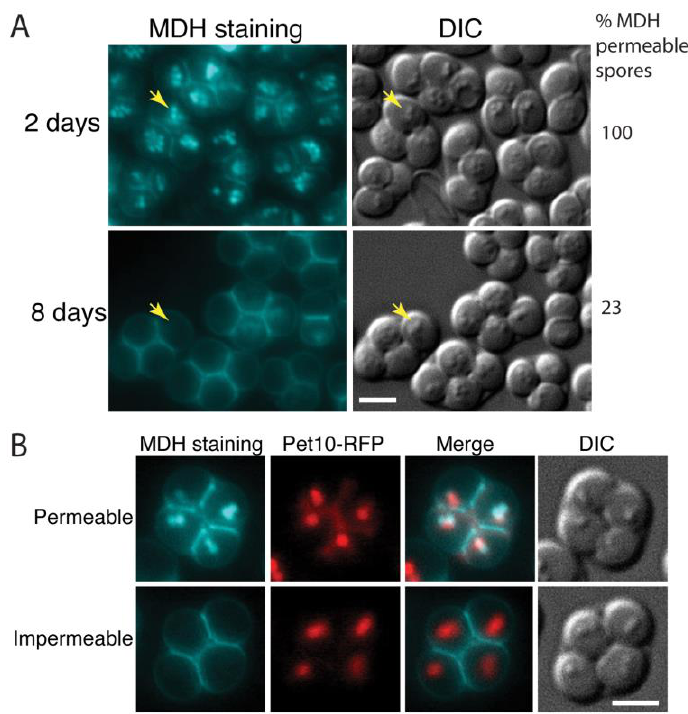
Figure 1. Older spores become impermeable to MDH. ( A ) Asci formed by the wild-type (AN120) strain after incubation on SPO plates for two days or eight days were stained with MDH and observed by fluorescence (blue staining) and light microscopy. The percentage of spores in the culture that displayed internal MDH staining is given at right (at least 500 spores counted). Yellow arrows indicate examples of lipid droplets visible by differential interference contrast (DIC) microscopy. Scale bar = 3 microns. ( B ) Five-day old asci of a wild-type strain expressing the lipid droplet marker Pet10-RFP (yKZ104) were stained with MDH and examined by fluorescence microscopy. Examples of asci containing MDH permeable or impermeable spores are shown. Scale bar = 3 microns.